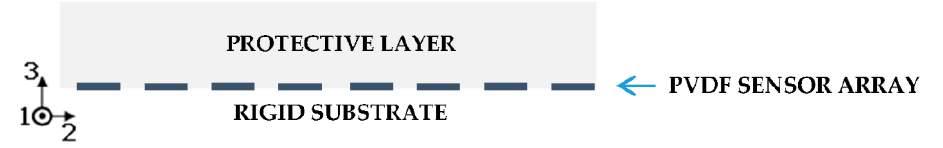
Figure 1. The PVDF sensor array is located on the bottom of the protective layer and integrated on a rigid substrate (side view).